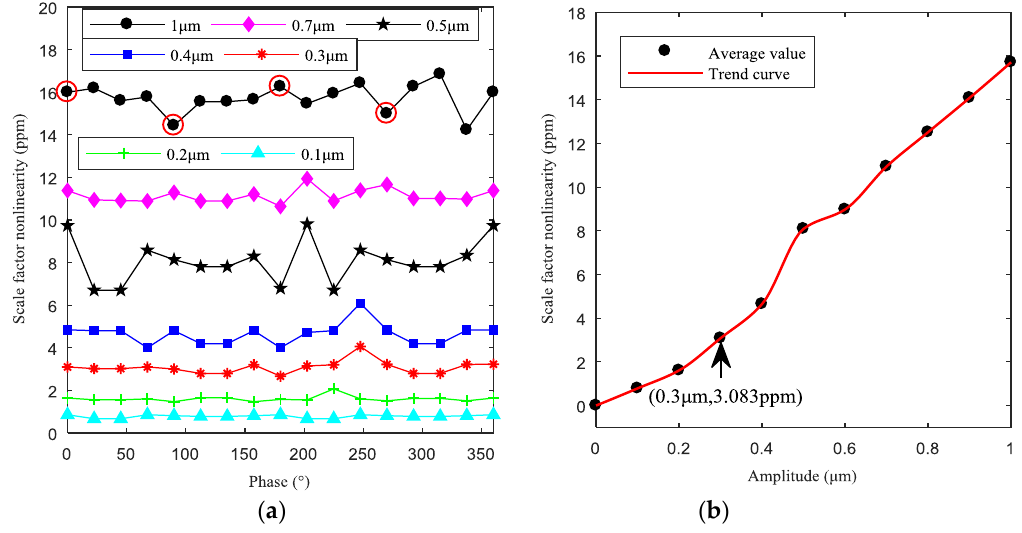
Figure 12. Scale factor nonlinearity: ( a ) Scale factor nonlinearities caused by different uneven capacitance gaps; ( b ) Effect of amplitudes of uneven capacitance gap on the average nonlinearity.